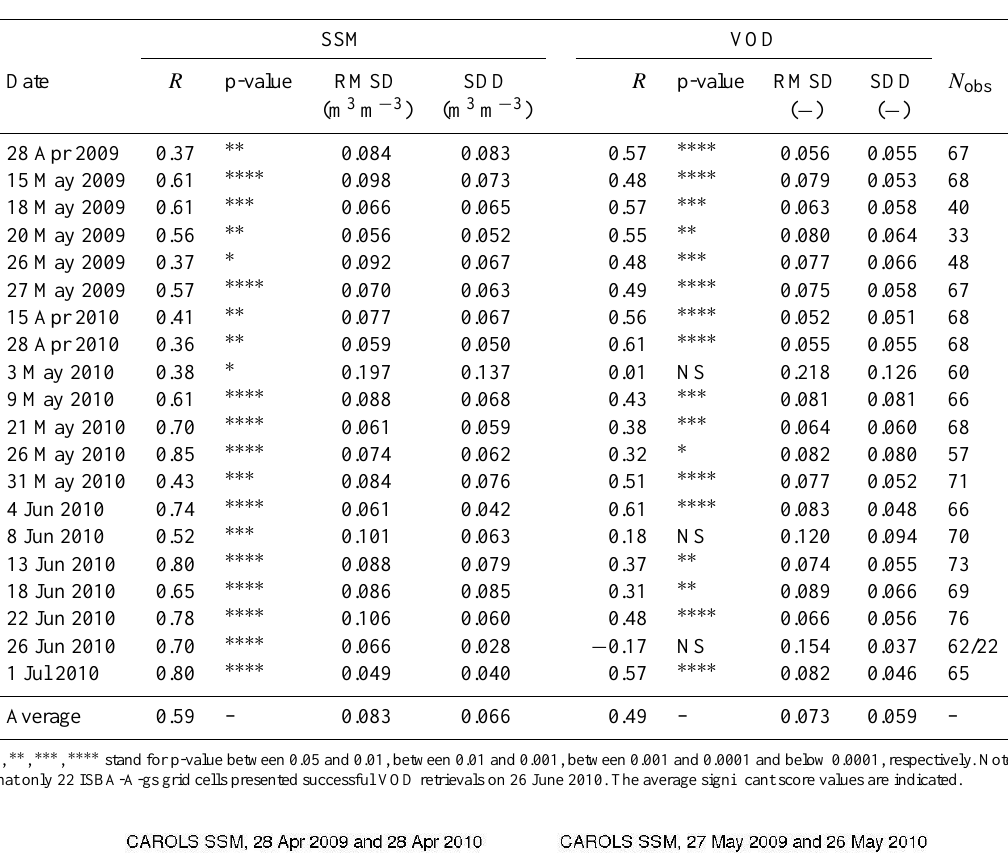
Table 2. Spatial correlation coefficient ( R ), p-value, RMSD and SDD (m 3 m − 3 for SSM) and number of grid cells taken for score calculation ( N obs ) between ISBA-A-gs and CAROLS SSM and VOD for 20 flights in 2009 and 2010.